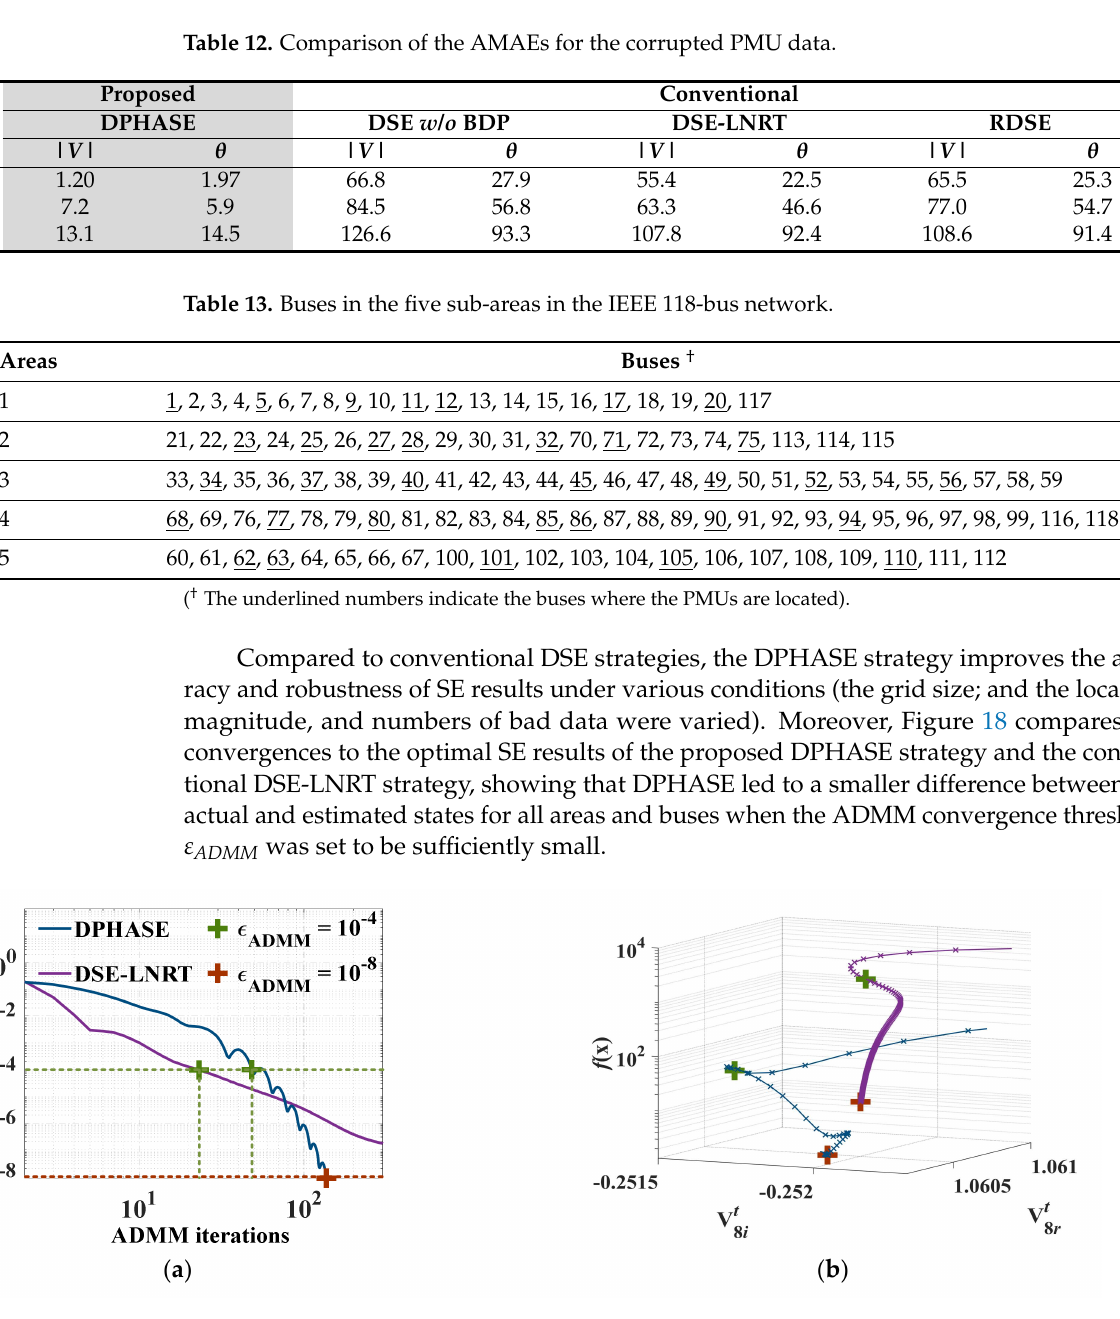
Figure 18. Variations ( a ) in the errors of the estimated states and ( b ) in the objective values, by the number of ADMM iterations for different convergence thresholds ε ADMM